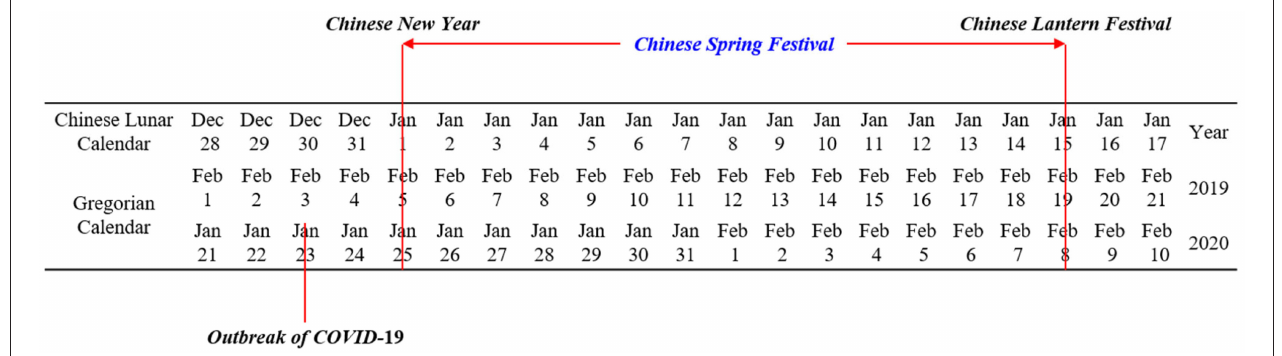
FIGURE 1 | Dates of fundamental events.